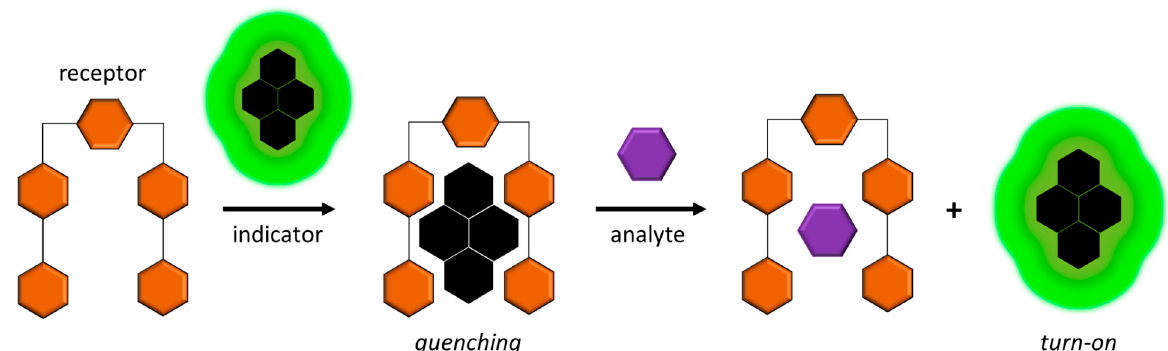
Figure 5. Principle of operation of indicator-displacement-based fluorescent chemosensors. The receptor (e.g., macrocyclic metal complex) sequesters the indicator, inhibiting fluorescence. The analyte of interest is added to displace the indicator, regaining fluorescence.